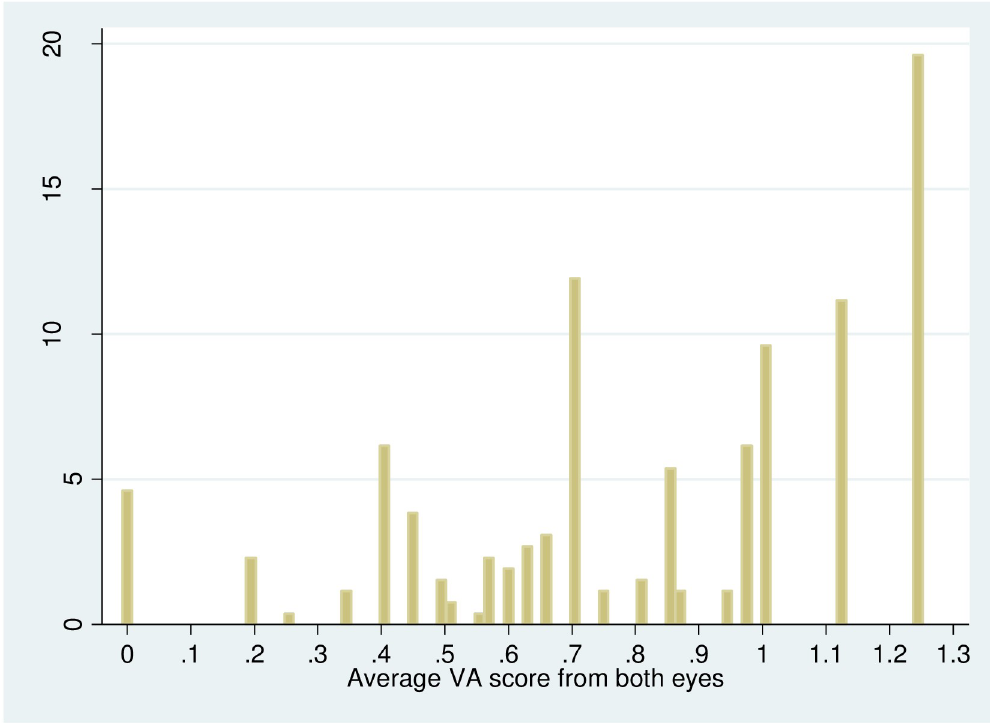
Fig 2. Raw results from the standardized eye examination. Number of observations = 260. Displayed are the average values from both eyes. Source: Own depiction.